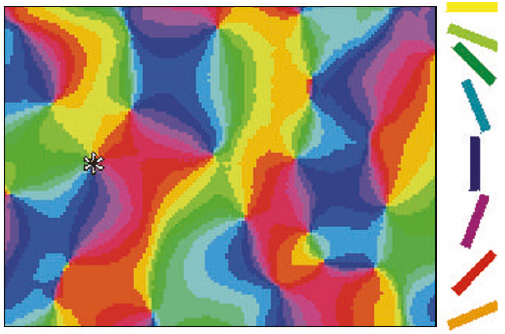
Figure 6: Orientation selectivity map (approximately a 3 mm × 3.5 mm area on cortical surface) from a layer of cat V1 parallel to the surface. The star indicates a singularity in the center of the pin- wheel organization. Some neurons in the pinwheel center possess closely overlapping and tight orientation selectivity, obtained from